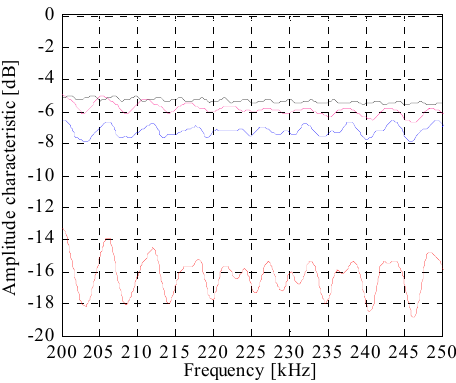
Figure 13. Amplitude characteristics of the faulted power line. The middle phase to the outer phase coupling. The fault distance is 25 km from the sending terminal. Legend: black-normal, blue-phase C broken, red-phase B broken, magenta-phase A broken.